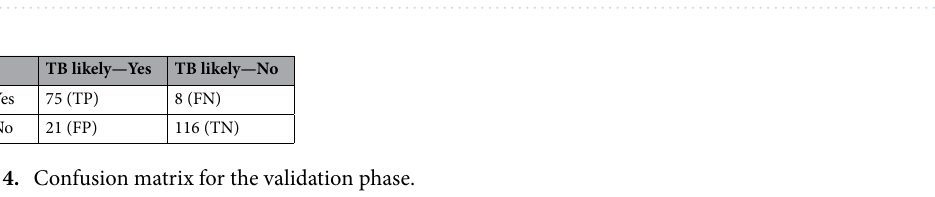
Figure 5. The provided graph shows the best ROC curve of a TB prediction model constructed using validation data.